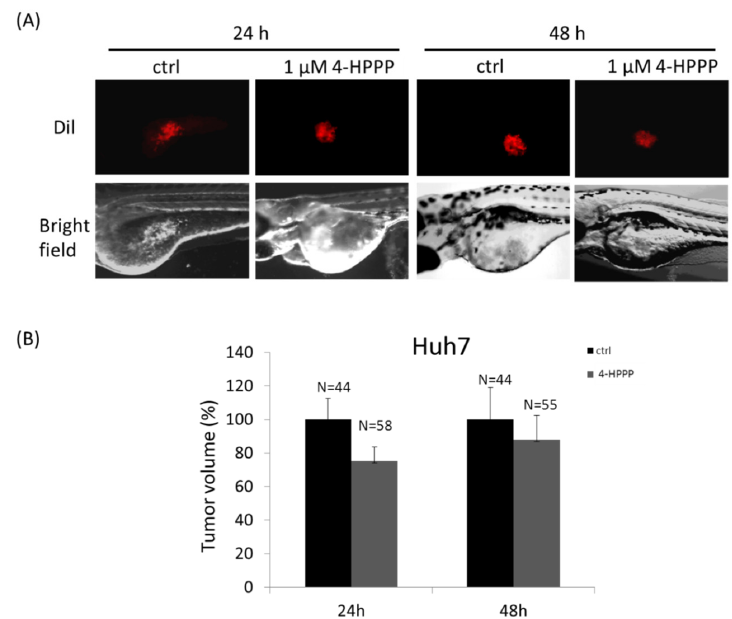
Figure 2. The inhibitory effect of 4-HPPP on anti-HCC using in vivo zebrafish xenograft assay. ( A ) A total of 200 Huh7 cells was microinjected into the yolk sac of the zebrafish embryos at 2 dpf (days post fertilization) and exposed to 1 μ M of 4-HPPP for 24 and 48 h respectively. ( B ) The quantitative analysis of tumor volume of ( A ). N stands for sample size.